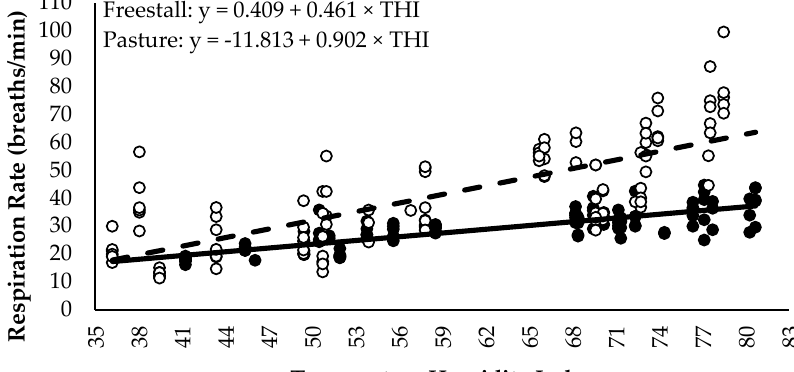
prepartum; calving: calving date; postpartum: 1 to 14 d postpartum.